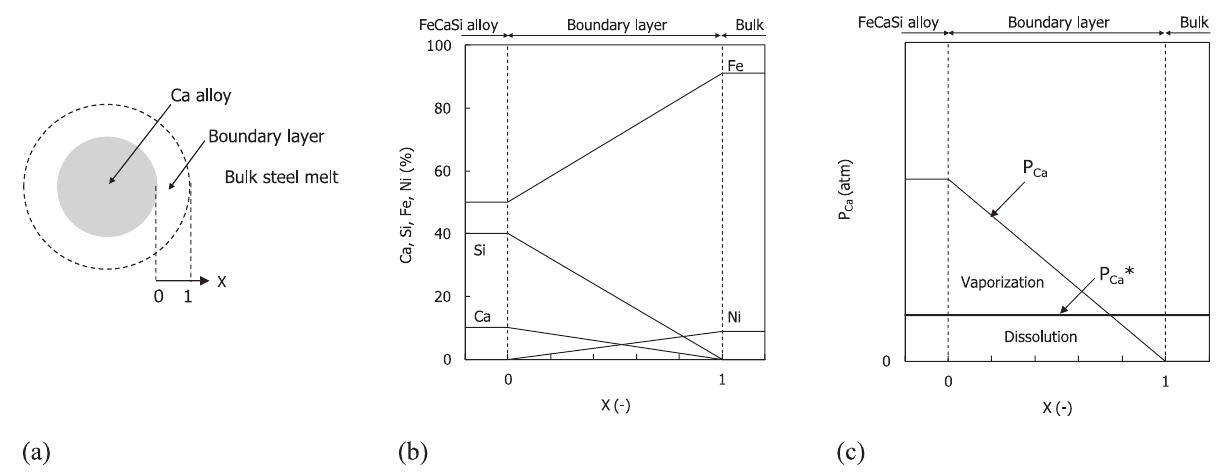
Fig. 5: Schematic illustrations of the calcium alloy during dissolution into the molten steel (a) and the profiles of the concentration (b) and vapor pressure (c) around the calcium alloy during dissolution. Fig. (c) was drawn on the tentative assumption of γ